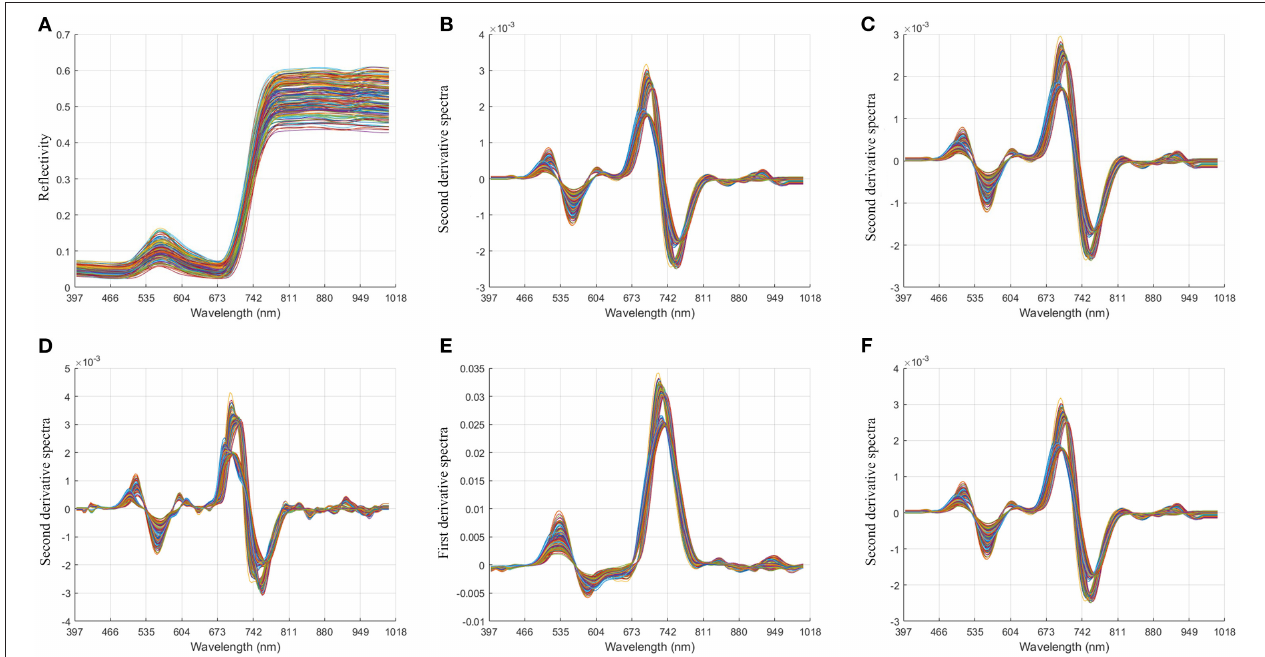
FIGURE 4 | Image comparison of unprocessed spectral data and preprocessed spectral data. (A) Original spectral data; (B) . multiplicative scatter correction + second derivative + Savitzky-Golay (17); (C) . multiplicative scatter correction + second derivative + Savitzky-Golay (19); (D) . multiplicative scatter correction + second derivative + Savitzky-Golay (7); (E) . multiplicative scatter correction + first derivative + Savitzky-Golay (5); (F) . multiplicative scatter correction + second derivative + Savitzky-Golay